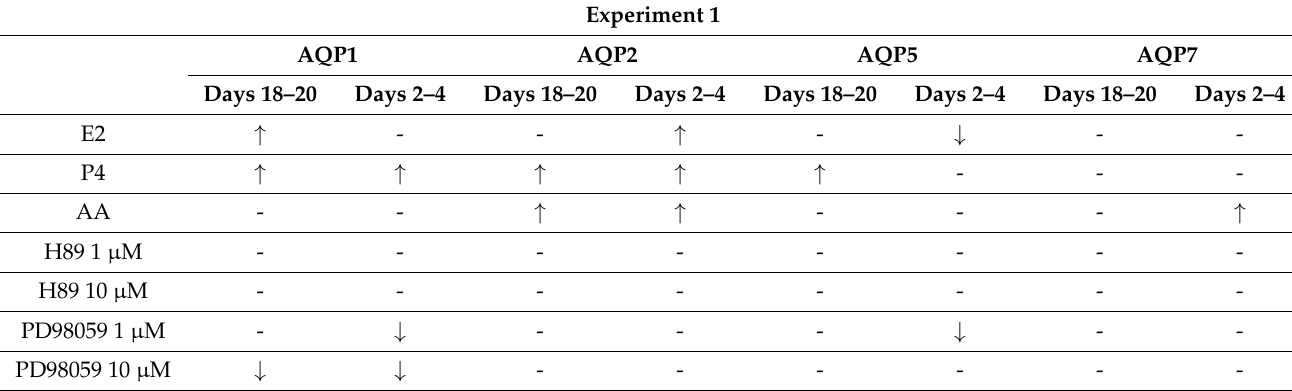
Table 3. A summary of the results from Experiment 1.